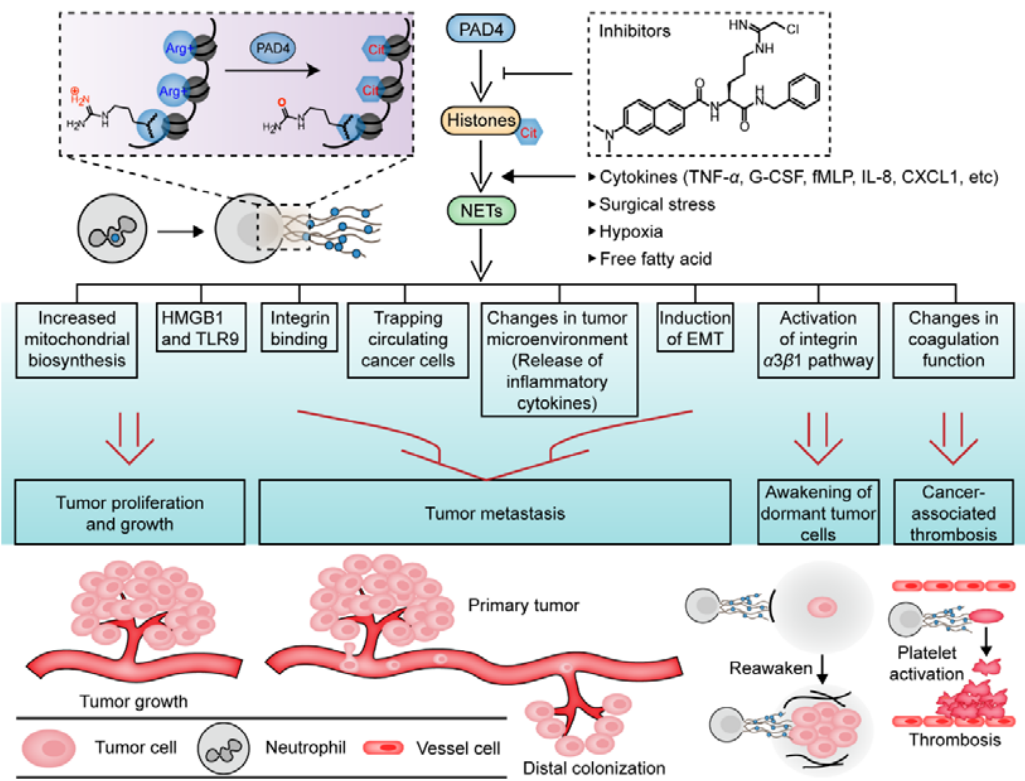
Figure 6. PAD4-mediated histone citrullination promotes NET formation, which in turn contributes to tumor progression and poor prognosis.